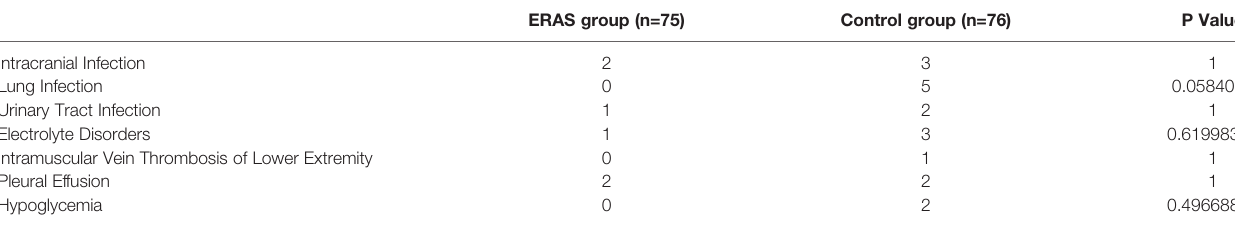
TABLE 2 | Postoperative complications in